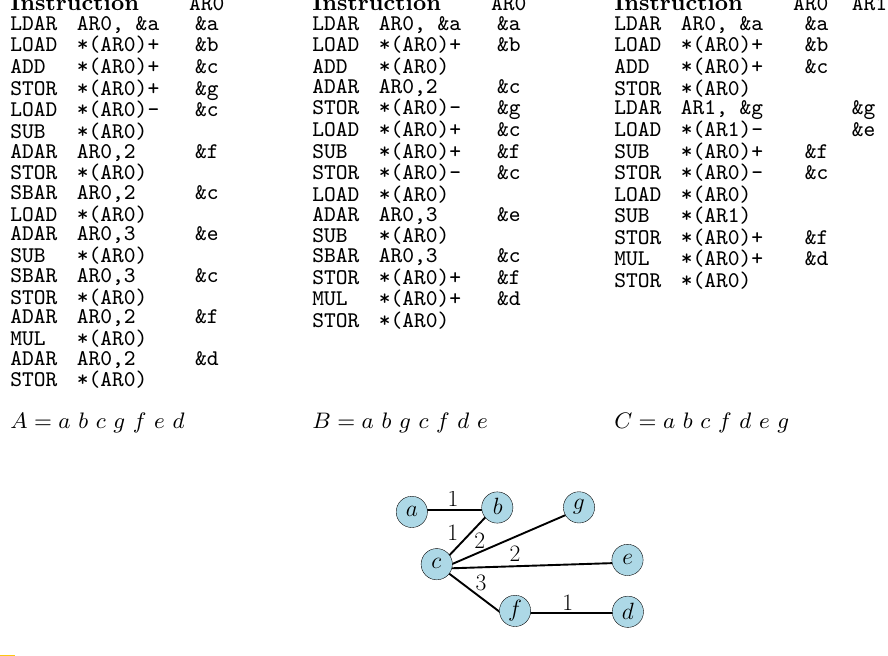
Figure 2 Access graph for the code fragment from Fig.